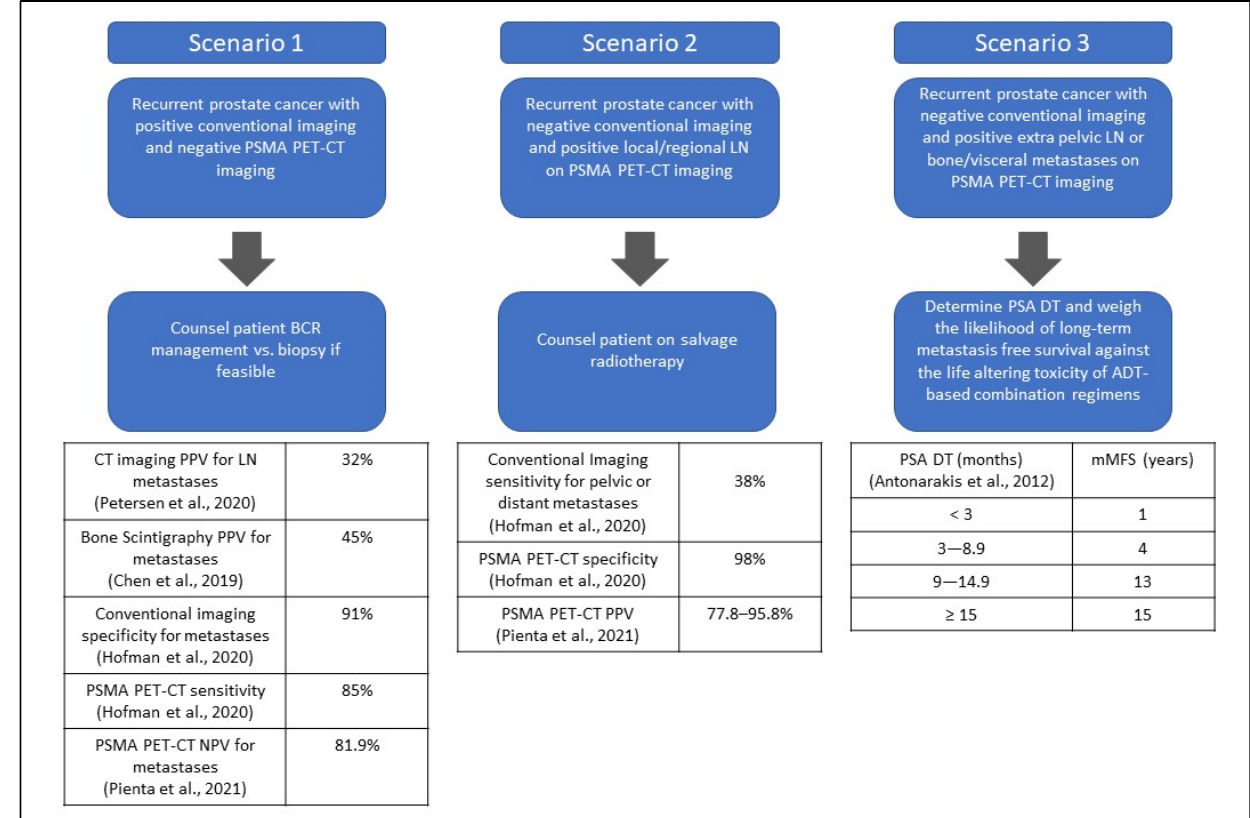
Figure 2. Summary of Clinical Scenarios [11,22,26,27,40]. The median metastasis free survival (mMFS) based on PSA DT for BCR prostate cancer and negative conventional imaging. 3.2.2. Scenario 2: A patient presents with biochemical recurrence with negative conven- tional imaging and positive local or regional lymph nodes (N1M0) by PSMA PET–CT imaging.